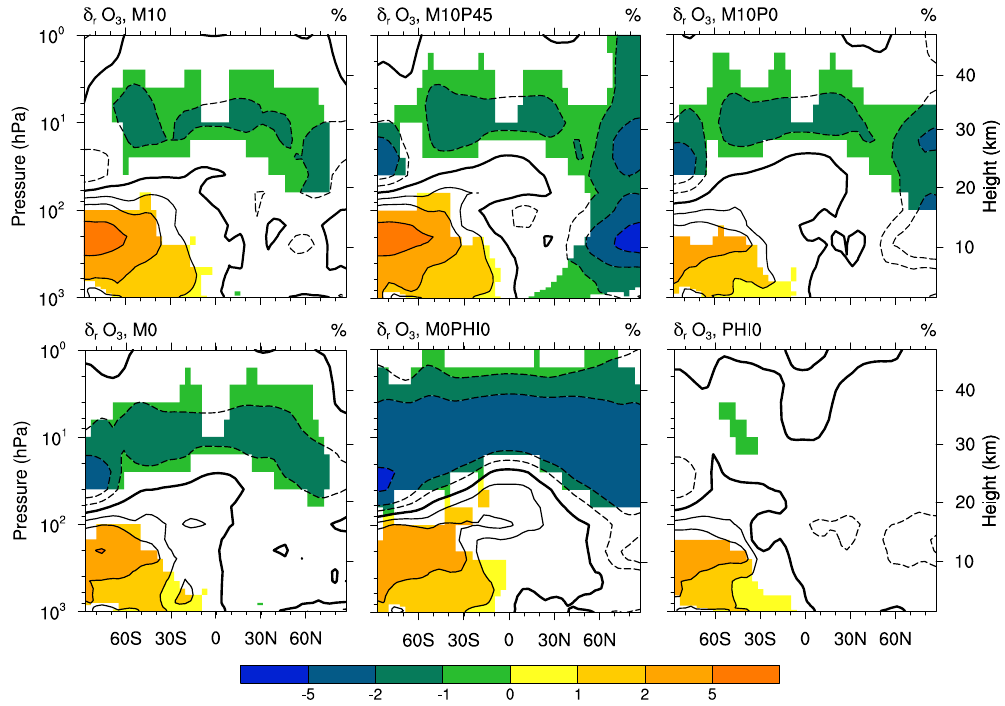
Figure 3. Simulated effects on zonally averaged mean annual ozone concentrations. Coloured areas are significant at a 5% level. Solid contours indicate positive, dashed contours negative